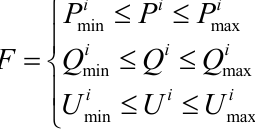
Figure 5. Constraints